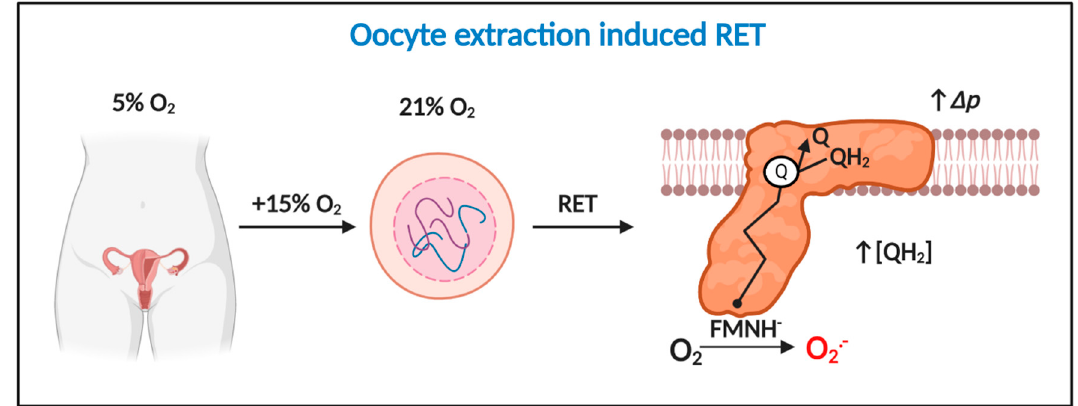
Figure 4. Oocyte extraction-induced RET is a potential temporally defined mechanism of mitochondrial superoxide production in assisted reproduction technologies (ART). Extracting oocytes induces a 15% increase in O 2 exposure, which drives considerable RET-dependent O 2 •− production provided ∆ p is near maximal and QH 2 is abundant. Extraction-induced light and damage could potentiate RET.